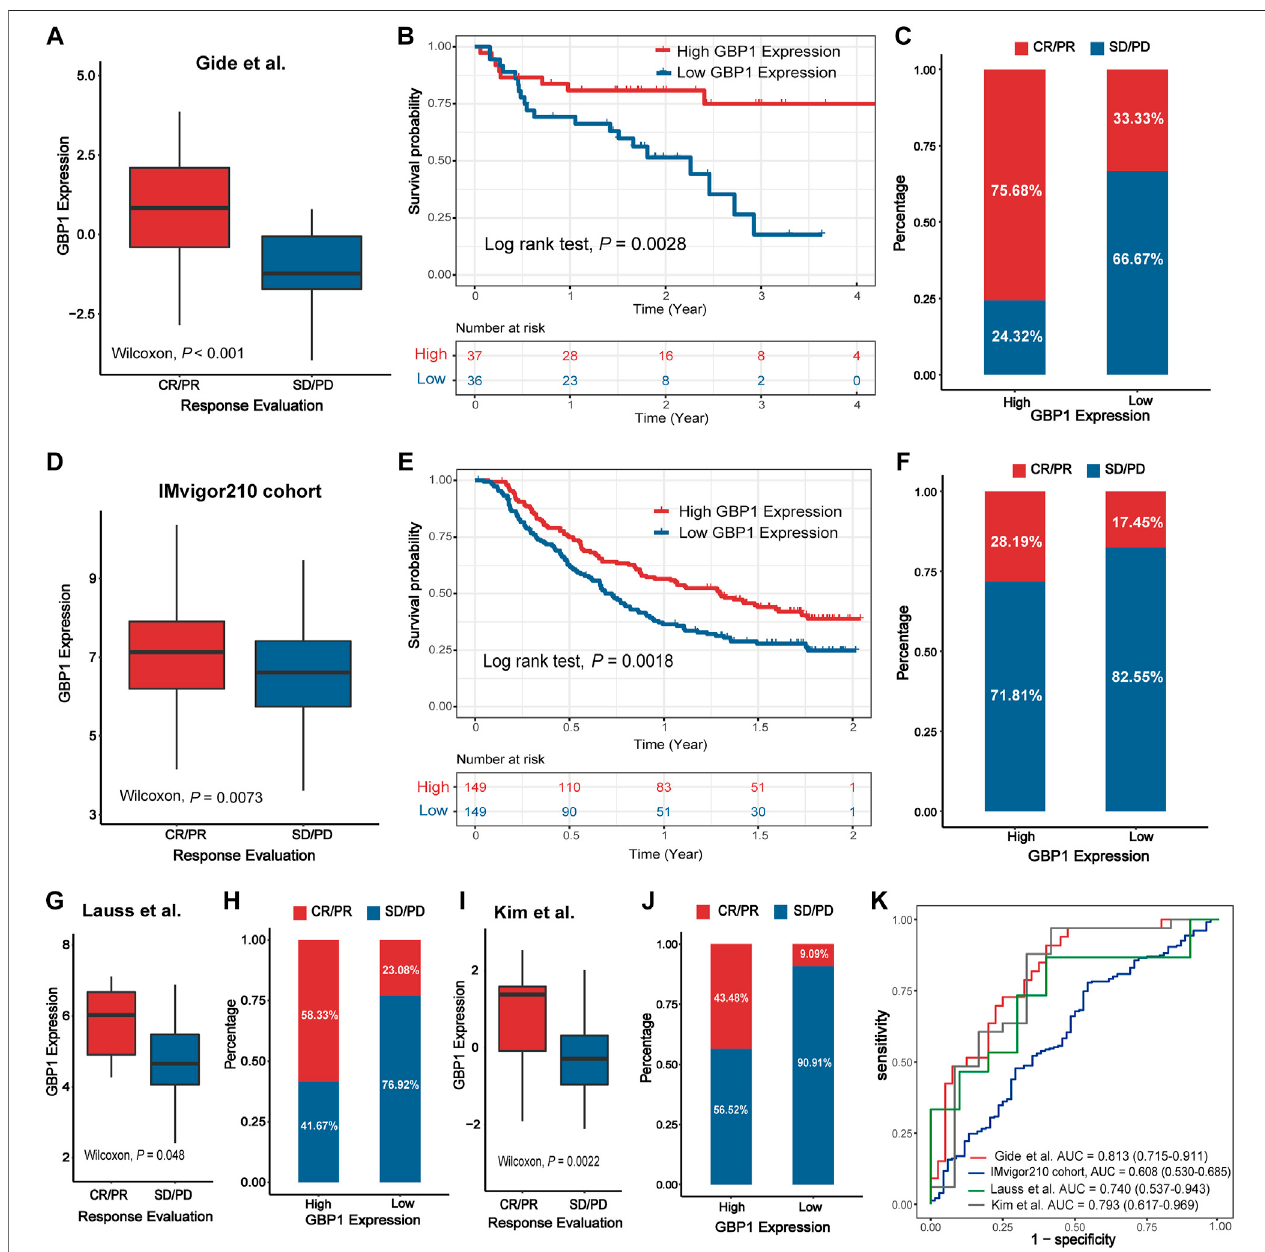
FIGURE 8 | Validation of the predictive capacity of GBP1 expression in immunotherapy. The expression level of GBP1 in groups with a different immunotherapy response status in the Gide et al. cohort (A) , IMvigor210 cohort (D) , Lauss et al. cohort (G) , and Kim.et al. cohort (I) . Kaplan – Meier curves for patients with high and low GBP1expression in theGideet al.cohort (B) and IMvigor210 cohort (E) .The proportion ofresponders (CR/PR) and non-responders (SD/PD) in the high and low GBP1 expressiongroupsintheGideetal.cohort (C) ,IMvigor210cohort (F) ,Laussetal.cohort (H) ,andKim.etal.cohort (J) .Receiveroperatingcharacteristics(ROC)for GBP1 expression in the four immunotherapy cohorts (K) . AUCs with 95% con fi dence interval (CI) were provided.